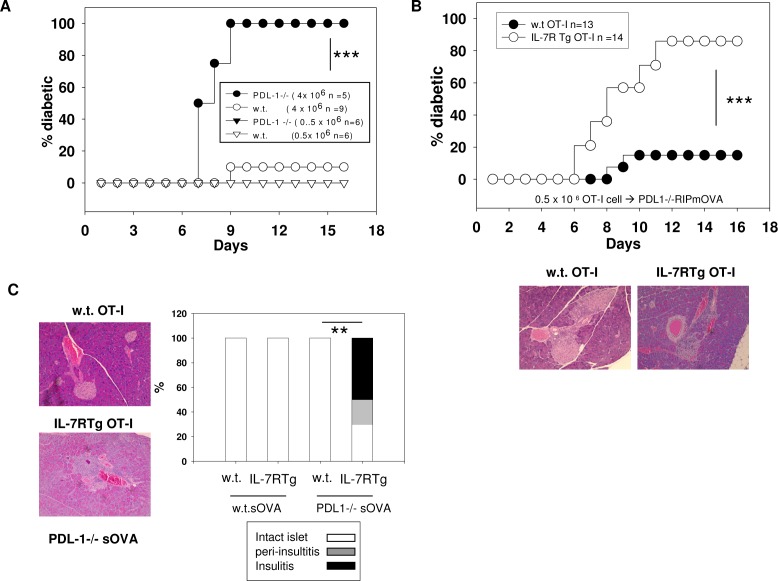
Forced expression of IL-7R and PDL-1 deficiency acts in synergy to promote cytotoxic response to self antigen.A: 4x 106 or 0.5x 106 w.t. OT-I T cells were injected into w.t. or PDL-1-/- RIP-mOVA mice (n = 5–9 in each group). The recipients were monitored for diabetes by urine analysis. *** p< 0.001 by log-rank test. B: 0.5 x 106 w.t or IL-7R Tg OT-I T cells were transferred into PDL-1-/- RIP-mOVA mice (n = 13–14 in each group). The recipients were monitored for diabetes by urine analysis. *** p< 0.001 by log-rank test. Representative H&E staining of the recipients’ pancreata are shown. C: 5 x 106 w.t. or IL-7R Tg OT-I T cells were transferred into w.t. or PDL1-/- RIP-sOVA mice (n = 5 in each group). Pancreata were collected from the recipients at day 14 after transfer. Representative H&E staining of the pancreata from the PDL1 -/- RIP-sOVA recipients are shown. Right: summary of insulitis (10 islets from each pancreas were scored as Fig 3B). ** p<0.01 by Mann-Whitney U test.